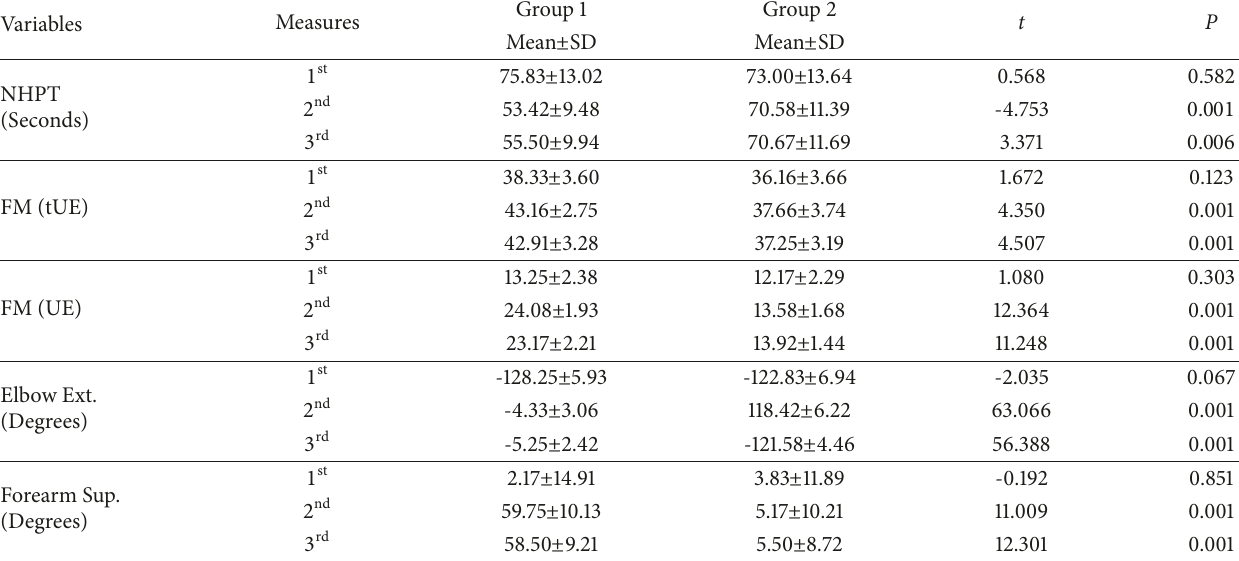
Table 2: Between group comparison. Data presented as mean and standard deviations (SD) in seconds (NHPT) and degrees (ROMs).